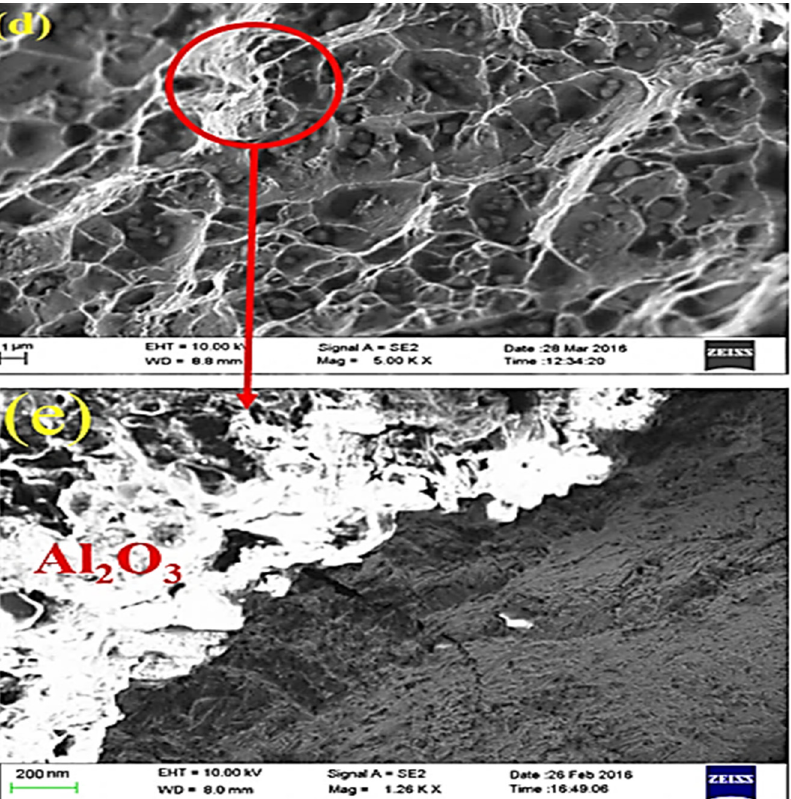
Figure 15. FESEM fractography of tensile samples ( a ) Nd-YAG laser-welded sample c; ( b ) Base metal; ( c ) Overlapped sample (A-2); ( d ) Annealed welded sample at 980 °C; ( e ) Close view of the selected portion.